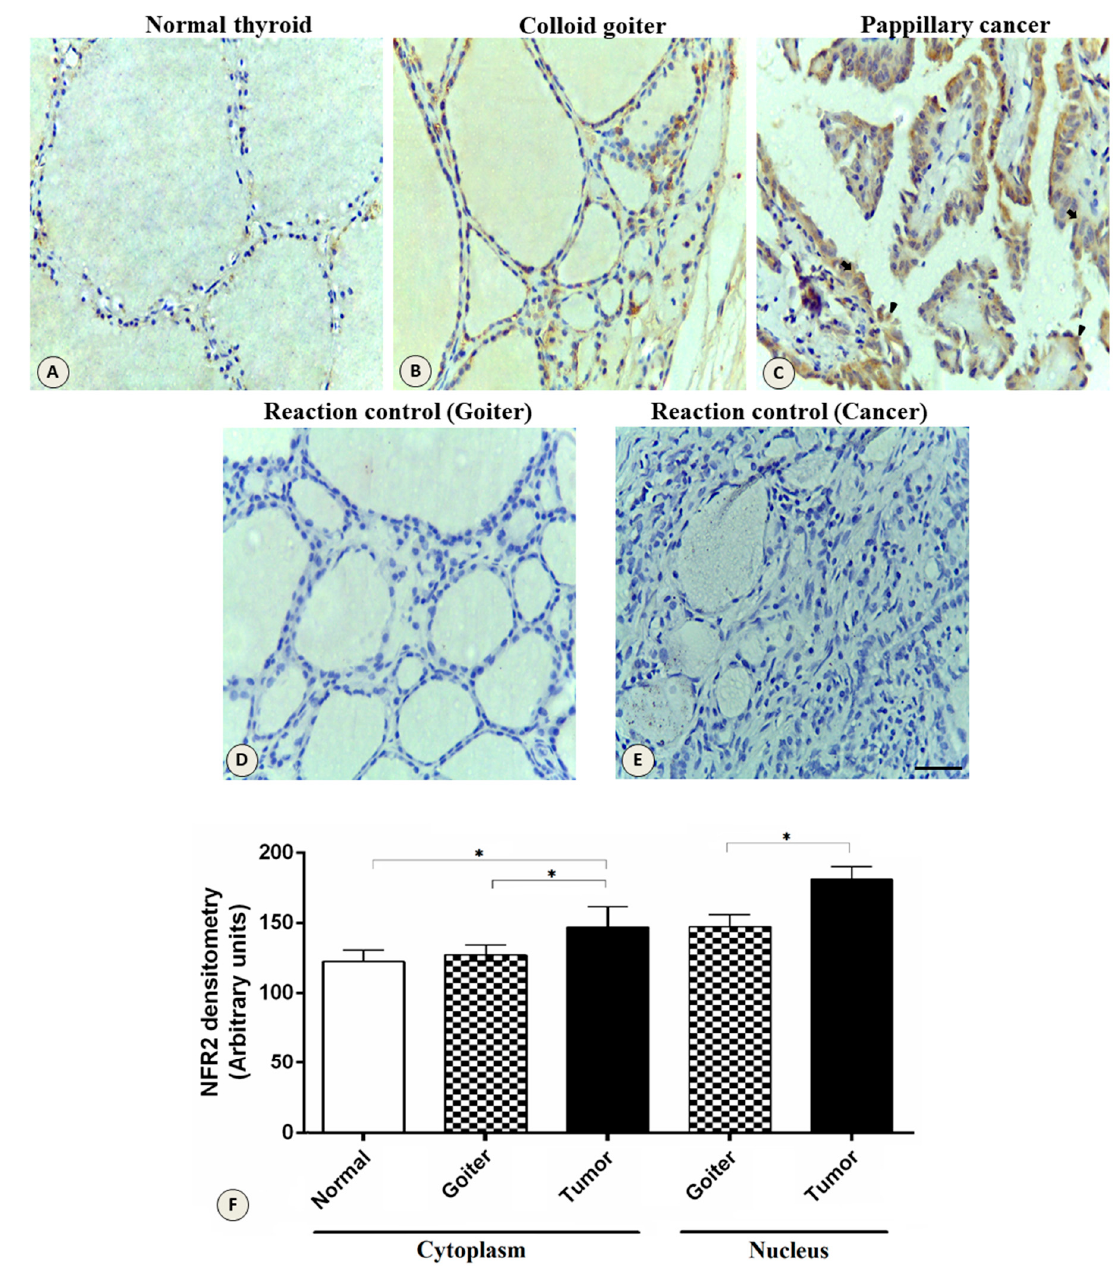
Figure 4. Expression of the NRF2 protein in the thyroid gland. Increased expression in the cytoplasm and nucleus in di ff erent tissues. ( A ) Normal thyroid tissue. ( B ) Colloid goiter. ( C ) Papillary thyroid cancer. ( D ) Negative controls of the goiter and ( E ) tumor. Section thickness, 5 µ m; contra-staining, hematoxylin; scale bars, 20 µ m. ( F ) Densitometric analysis of NRF2 quantification. The data represent the mean ± SEM of the densitometric index. *, p < 0.0001; bar size, 20 µ m; arrows, cytoplasm; arrowhead, nucleus.